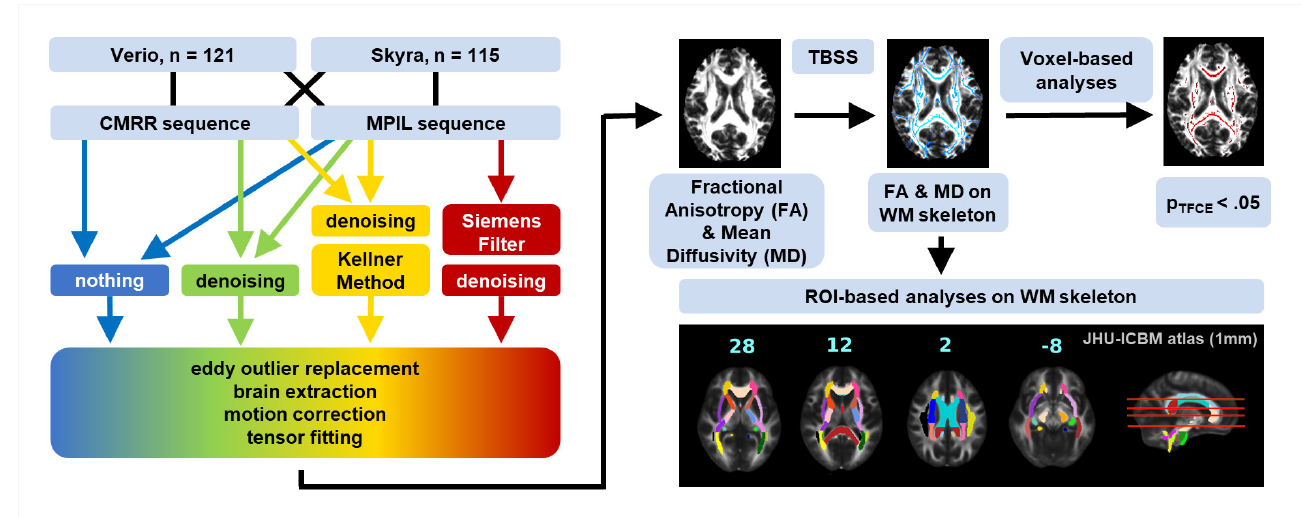
Figure 1. Analysis outline. DW images were collected at 3T Siemens Magnetom Verio and Skyra fit with CMRR [57] and MPIL (Siemens product sequence) sequence respectively, resulting in four datasets. Each dataset from the MPIL sequence was processed with four different pipelines: no filtering (blue), denoising (green), denoising + unringing by “Kellner Method” (yellow) [48] and Siemens low-pass window filtering + denoising (red); datasets from the CMRR sequence were processed with three different pipelines (Siemens low-pass window filtering was not applied). Standard preprocessing steps followed these pre-filtering steps. By tensor fitting obtained FA and MD maps were skeletonised with tract-based spatial statistics (TBSS) [42] and fed into voxel-wise as well as ROI-based analyses on white matter (WM) skeleton.